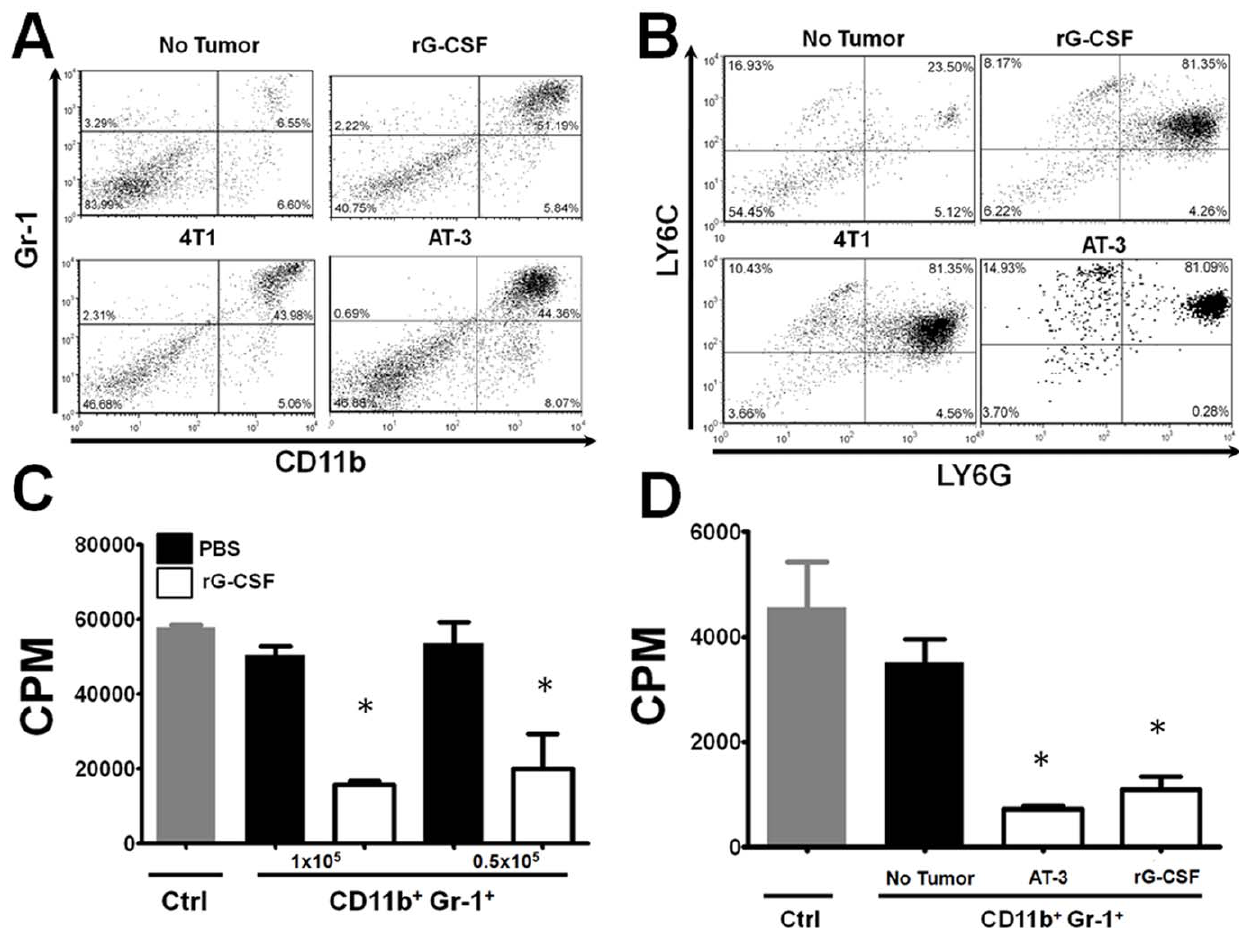
Figure 2. Recombinant G-CSF promotes immunosuppressive myeloid cells. ( A ) Phenotypic analysis for co-expression of CD11b and Gr-1 markers on unfractionated splenocytes from mice injected with recombinant G-CSF protein, 4T1 or AT-3 tumor cells (tumor volumes approximately 1000 mm 3 ) (as in Fig. 1). Values shown in the upper right quadrant of each dot plot reveal the percentage of the CD11b + Gr-1 + myeloid fraction. Data are representative of 3 separate experiments for each group. ( B ) CD11b + cells in panel A were gated and then re-plotted for expression of the Ly6G and Ly6C markers to determine the proportion of granulocytic (upper right) and monocytic (upper left) MDSC subsets within each group. Data are representative of 3 separate experiments for each group. ( C ) Ability of CD11b + Gr-1 + isolated from control (PBS) or G-CSF-treated mice to suppress anti-CD3 mAb-stimulated CD3 + T cells (1 6 10 5 /well) at the indicated cell densities. CD11b + Gr-1 + cells from G-CSF, but not vehicle (PBS)-treated mice significantly suppressed T cell proliferation compared to the control (i.e., no CD11b + Gr-1 + cells added; * P , 0.01). ( D ) As in C , CD11b + Gr-1 + cells from G- CSF-treated or AT-3 tumor-bearing mice significantly (* P , 0.02) suppressed allo-specific (H-2 b anti-H-2 d ) T cell proliferation compared to control without CD11b + Gr-1 + cells. Responders (1 6 10 5 /well) and stimulators (2 6 10 5 /well) from unfractionated splenocytes were incubated together with or without isolated CD11b + Gr-1 + cells from the indicated mice (1 6 10 5 /well). In both C & D , proliferation was measured by 3 H-thymidine uptake (mean 6 SEM) of triplicate determinations and are representative of two separate